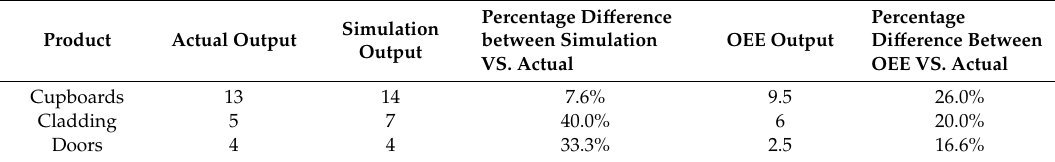
Table 6. Output Comparison per shift.